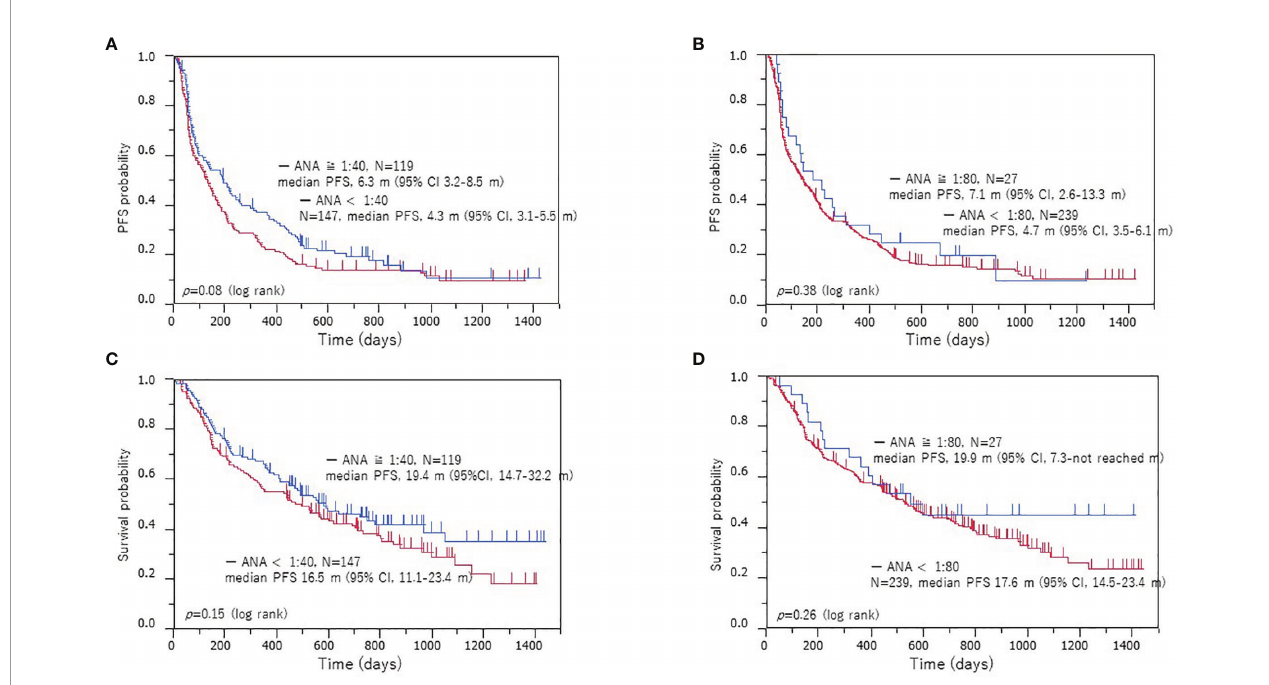
FIGURE 2 | Kaplan – Meier survival curves of PFS and OS according to ANA positivity in the low and high cohorts. PFS (A) and OS (B) when a positive ANA cutoff of 1:40 was used, PFS (C) and OS (D) when a positive ANA cutoff of 1:80 was used. Survival analysis with ICI treatment: no signi fi cant difference in the PFS and OS was observed between the ANA-positive and ANA-negative patients or high and low ANA titer cohorts. PFS, progression-free survival; OS, overall survival; ANA, anti-nuclear